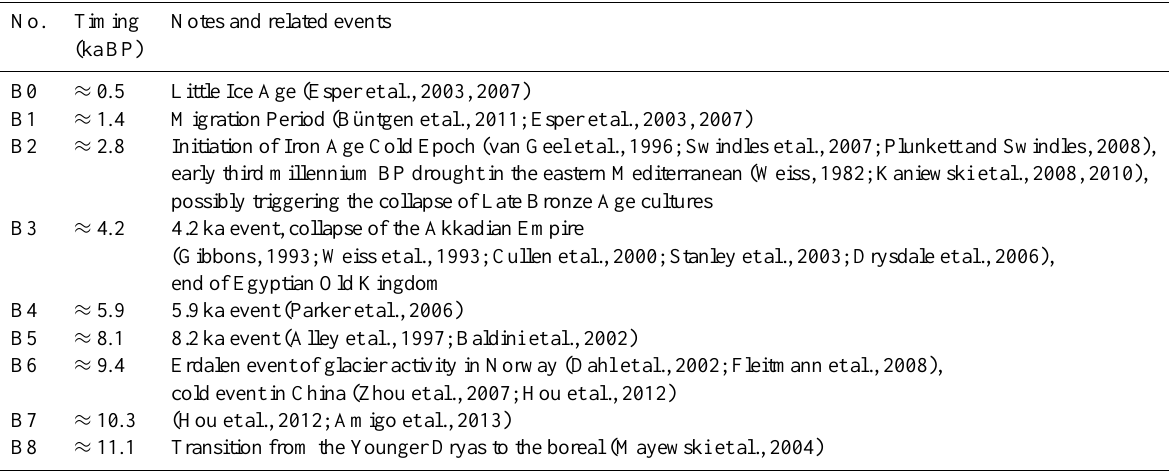
Table 3. List of Bond events and potentially related cultural changes (selection).